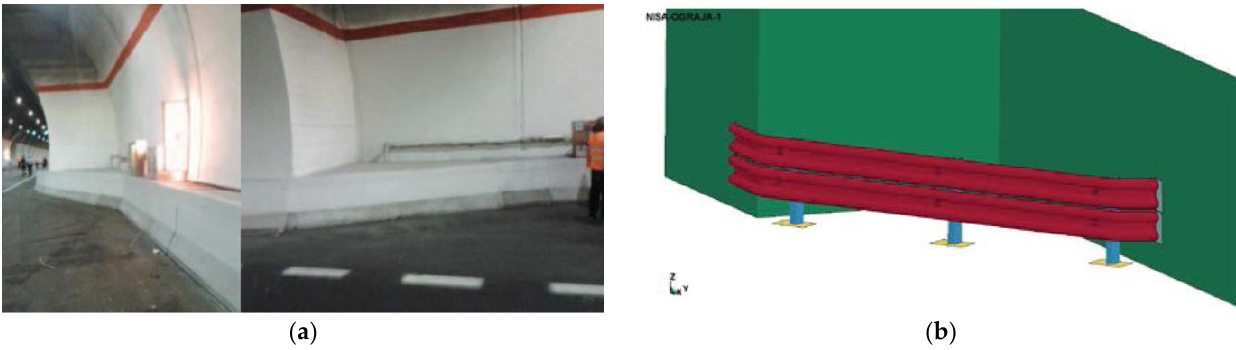
Figure 3. Protection measures of the tunnel lay-by end-wall. ( a ) protection of the edge of the end-wall with in-situ concrete ( a ) [41] or angled concrete barrier ( b ) [2,28].